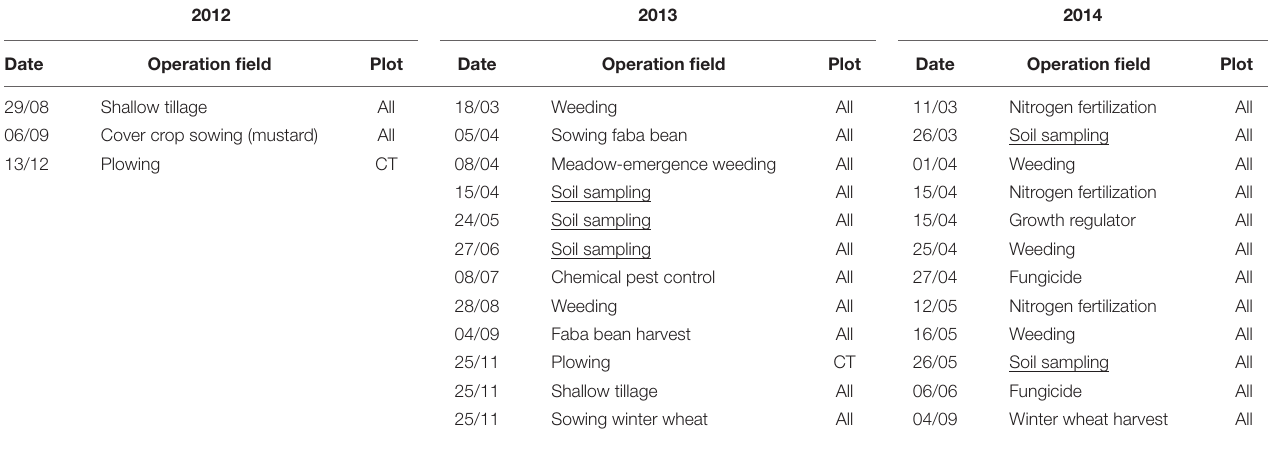
TABLE 1 | Field operations performed on the SOLRESIDUS experiment in 2012 and